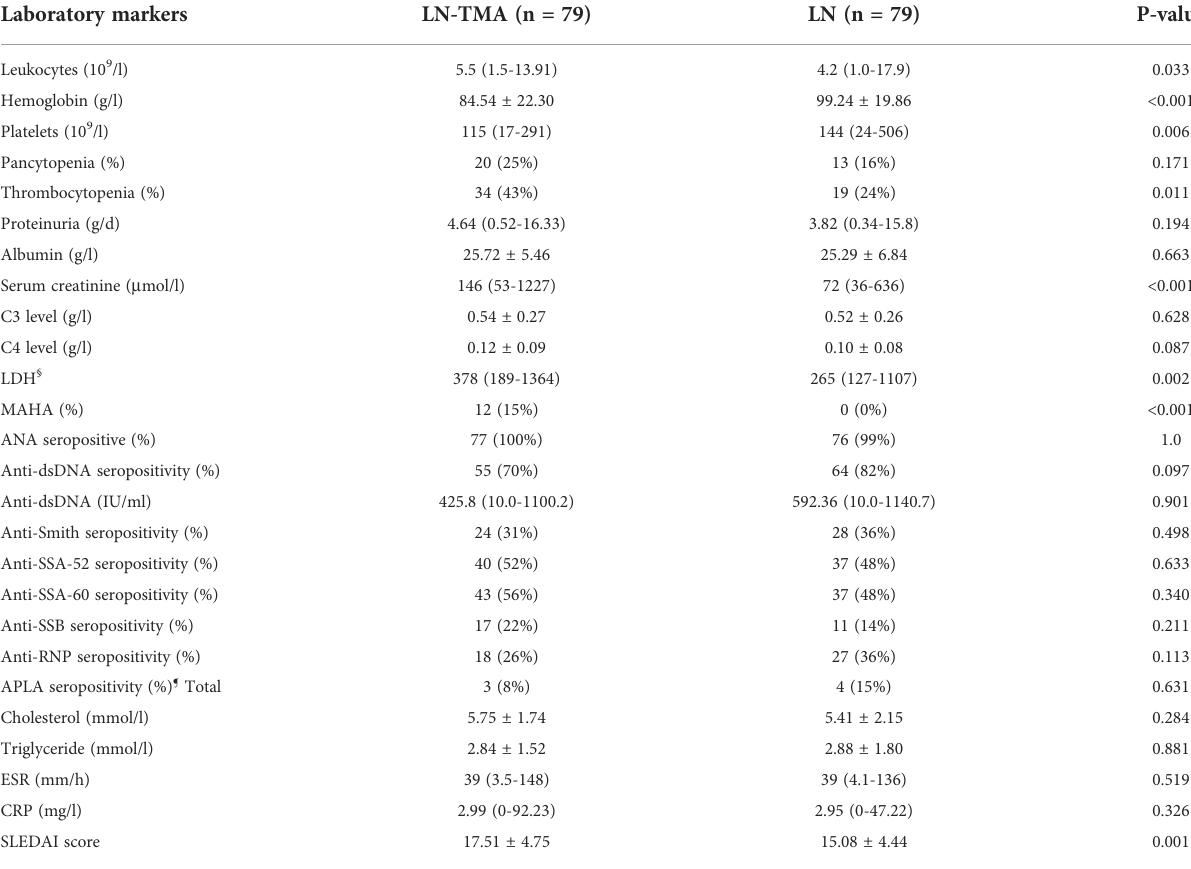
TABLE 2 Laboratory parameters of lupus nephritis patients with or without renal thrombotic microangiopathy. Laboratory